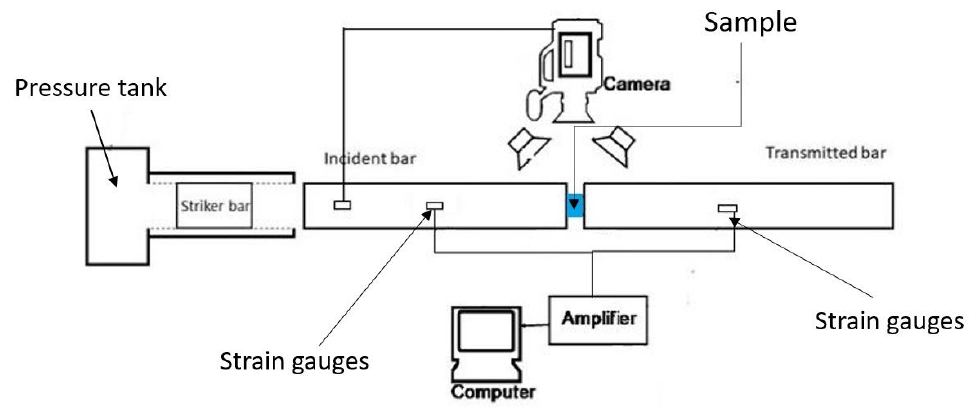
Figure 2. Schematic set up of the